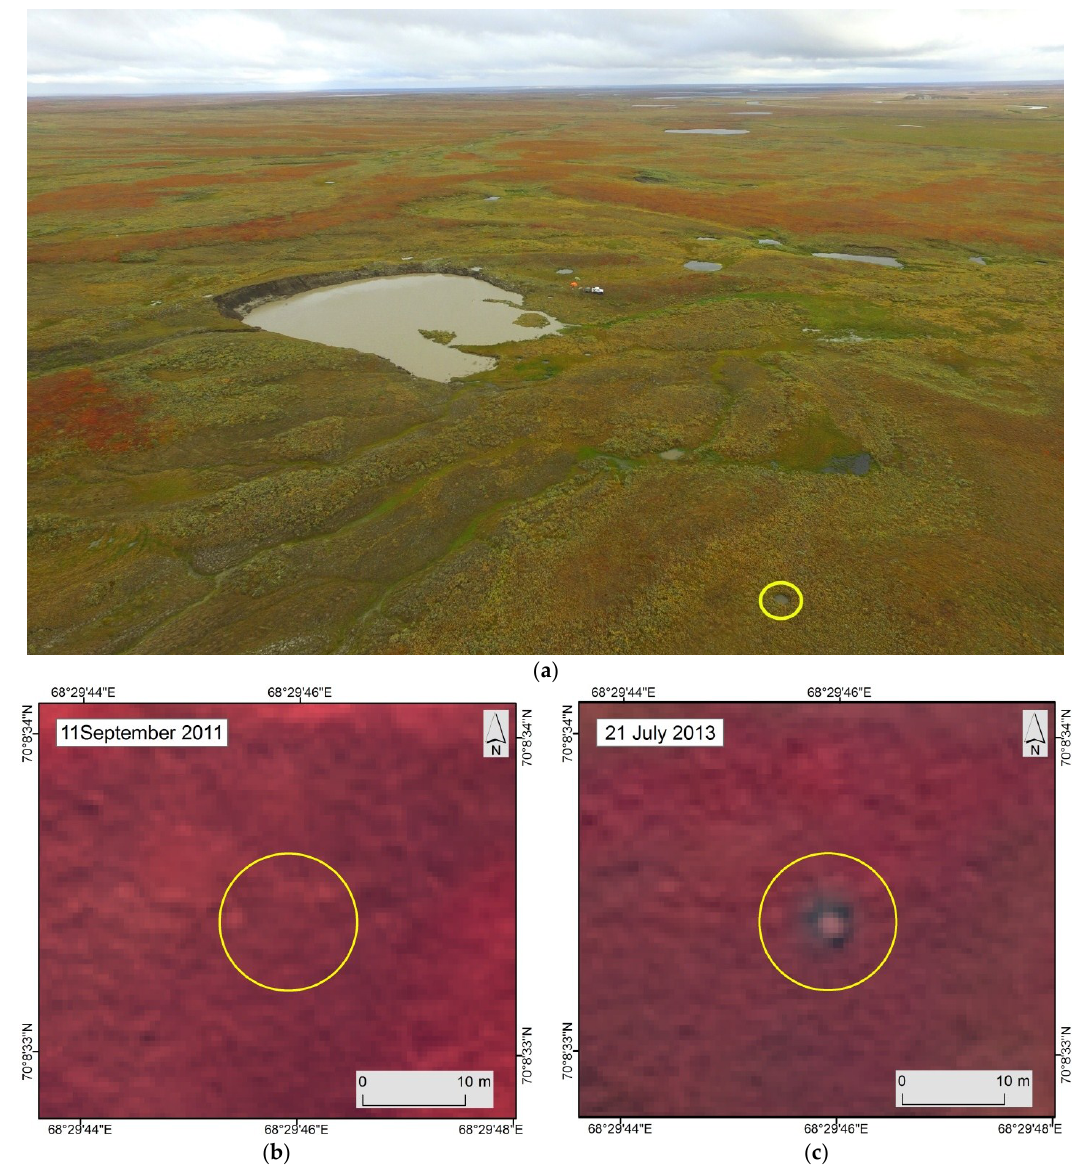
Figure 9. Impact hollow, located 217 m south of the GEC-2 AMP: ( a ) an oblique photograph from the UAV on 07 September 2017; ( b ) no impact hollow before the formation of GEC-2 on WorldView-2 image of 11 September 2011, synthesis of NIR + Red + Green; ( c ) an impact hollow, which appeared on WorldView-2 image of 21 July 2013, synthesis of NIR + Red + Green.